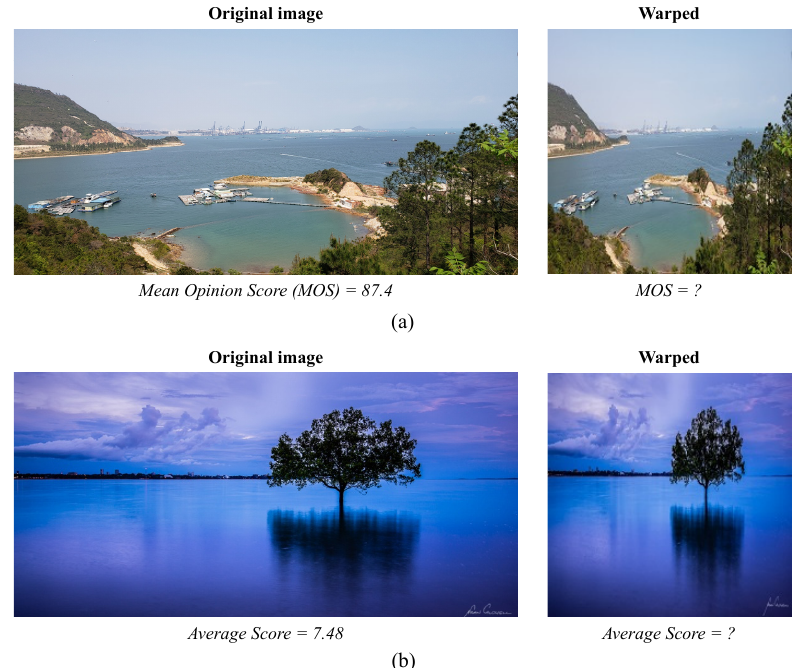
Figure 1. Two original images with annotated scores (MOS or average score) as well as the correspond- ing images warped to a fixed size. ( a ) An example image from a TQA database [23]. ( b ) An example image from an AQA database